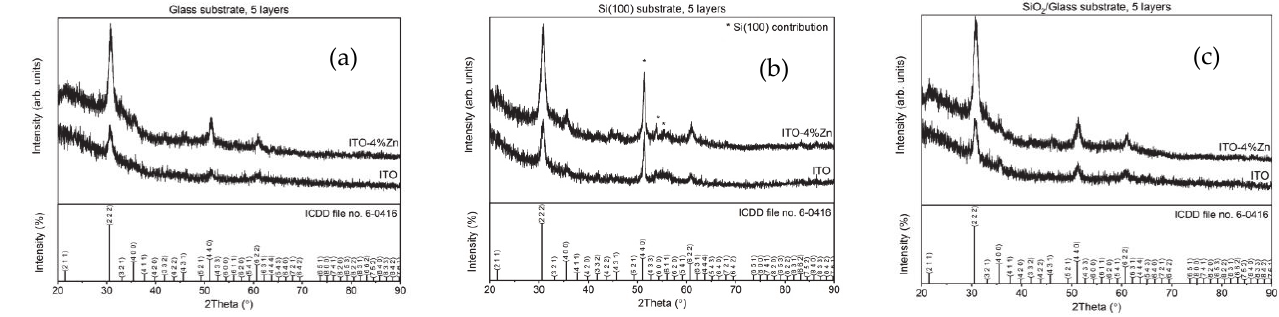
Figure 5. XRD patterns of ITO films undoped and doped with 4% Zn deposited on ( a ) glass, ( b ) Si, and ( c ) SiO 2 /glass.